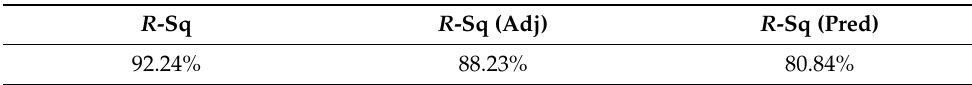
Figure 5. Response analysis of design of experiment for UTS. Table 6. R value for UTS by RSM.